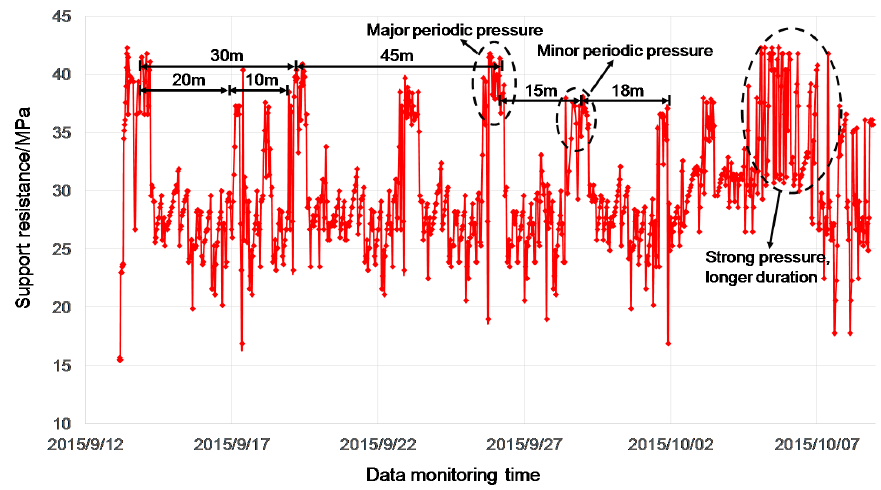
Figure 4. Roof weighting at alternate long and short intervals.